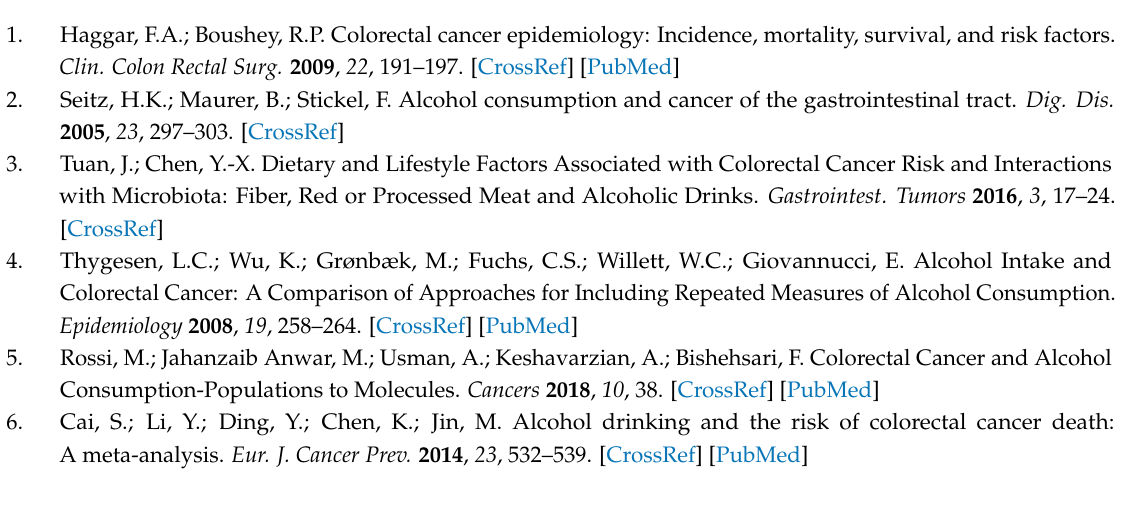
Figure S1: Ethanol induces ER stress in HT29 and Caco-2 colon cancer cells, Figure S2: Effects of ethanol on Nrf2 and HO-1 in HT29 and Caco-2 colon cancer